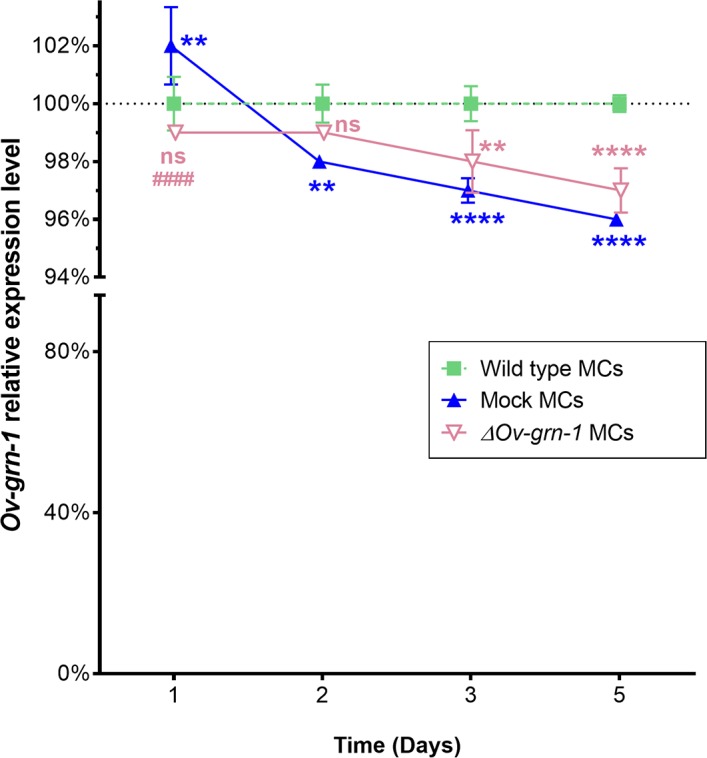
CRISPR/Cas9 ineffective at silencing gene expression in metacercariae (MC).Expression of Ov-GRN-1 mRNA in WT, mock-transfected, and ΔOv-GRN-1 MC over 5 days as quantified with qPCR and plotted relative to the WT untreated group; mean ±SD from three replicates. Note: Curves have been adjusted horizontally ±0.02 time units and a broken axis used with a condensed lower section to enhance data visualization. Using two-way ANOVA Holm-Sidak multiple comparisons test to compare groups at each time point: p > 0.05 = non-significant (ns) difference; **P ≤ 0.01; and ****p ≤ 0.0001 represent ΔOv-GRN-1 (pink) or Mock (blue) MC compared to WT control group (green), ####p ≤ 0.0001 represents ΔOv-GRN-1 compared to mock MC group.